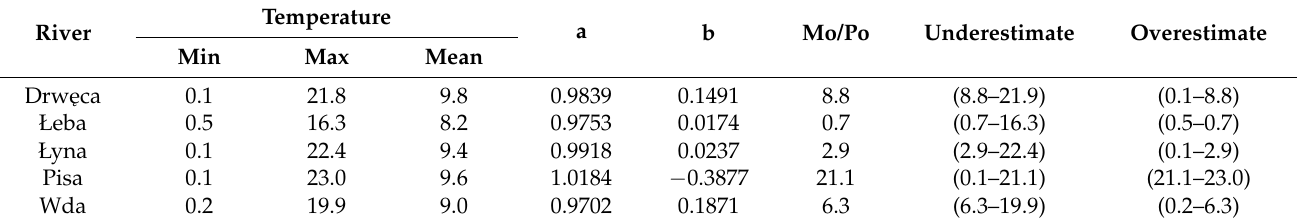
Table 3. The quality of the prediction of river water temperatures was based on the multilayer perceptrone network/g model based on lake water temperature and air temperature from three meteorological